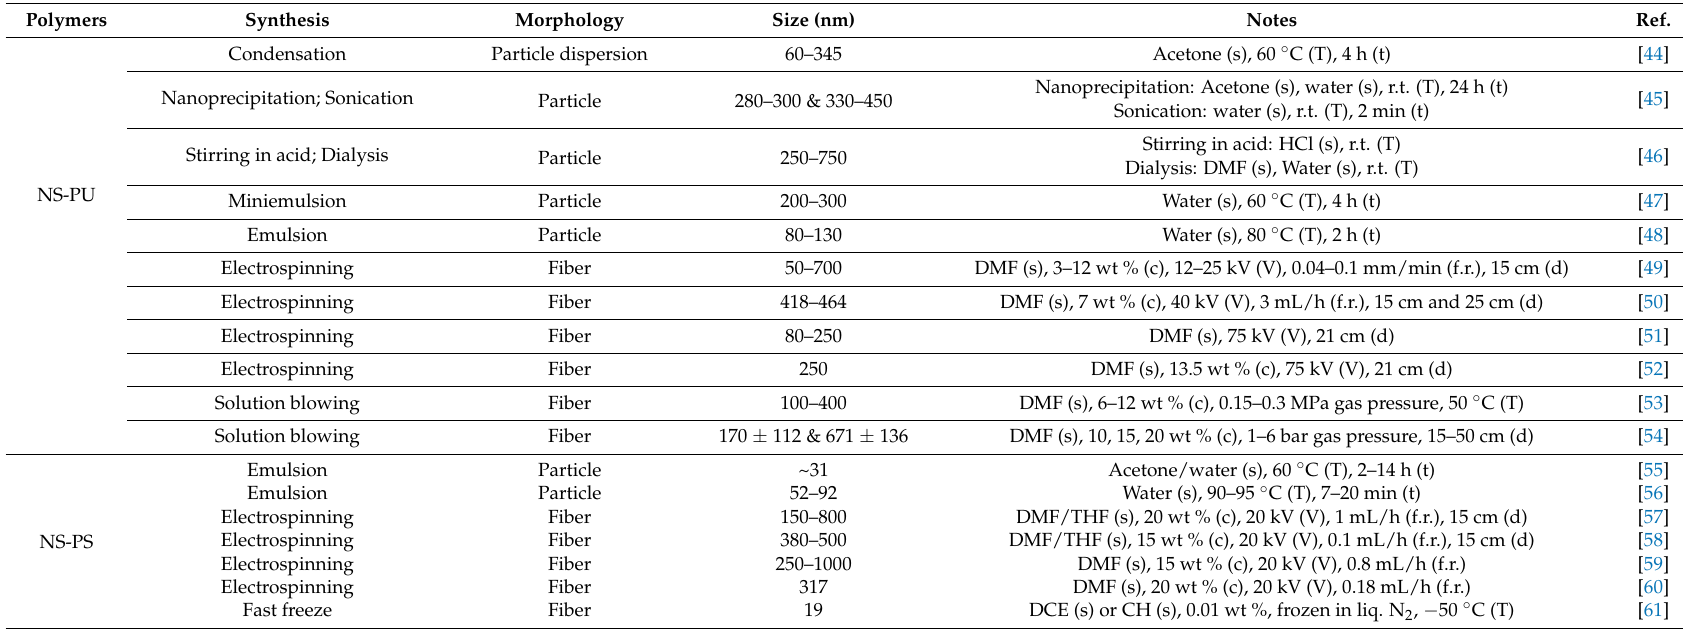
Table 2. Nanostructured PU, PS, PAN and